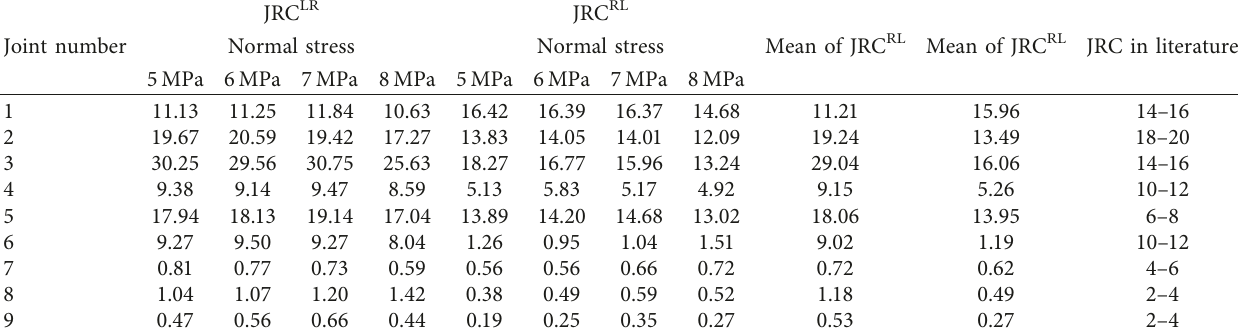
Table 9: JRC RL and JRC RL values of 9 target